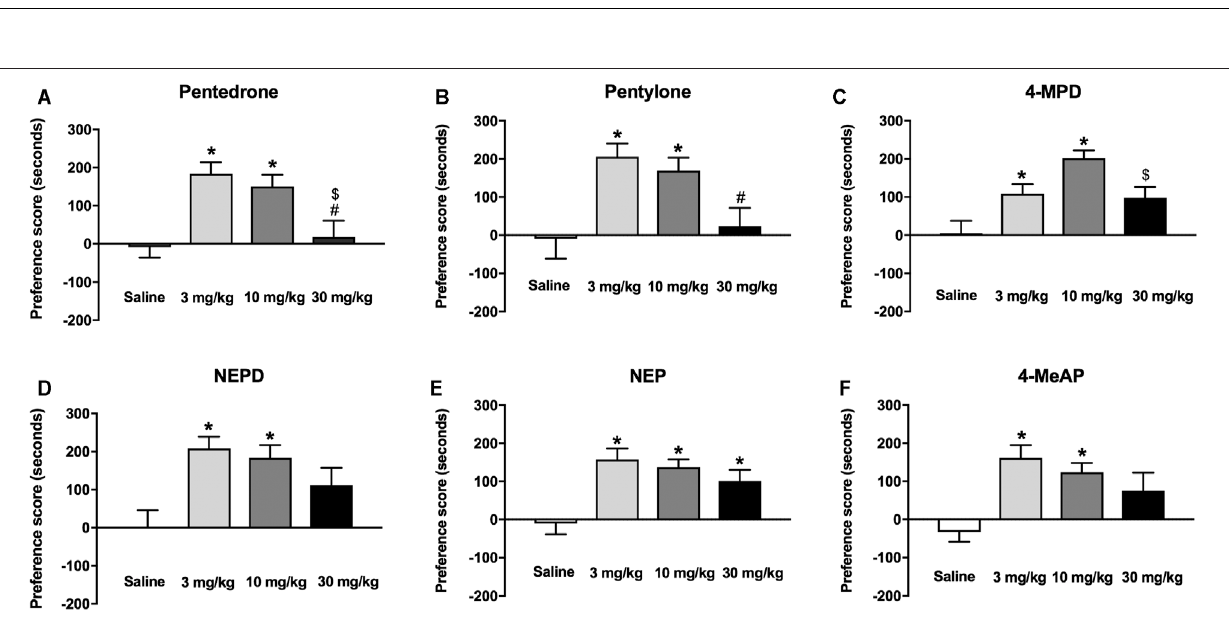
FIGURE 6 | Effectsof pentedrone (A) , pentylone (B) , 4-MPD (C) , NEPD (D) , NEP (E) , and 4-MeAP (F) on the CPP test in mice. Bars represent the mean ± SEM of the preference score (difference between the time spent in the drug-paired compartment on the test day and the preconditioning day). Tukey ’ s multiple-comparisons test; * p < 0.05 vs the saline group; # p < 0.05 vs the 3 mg/kg dose group; $ p < 0.05 vs the 10 mg/kg dose group ( N (cid:2) 12 – 14/group).